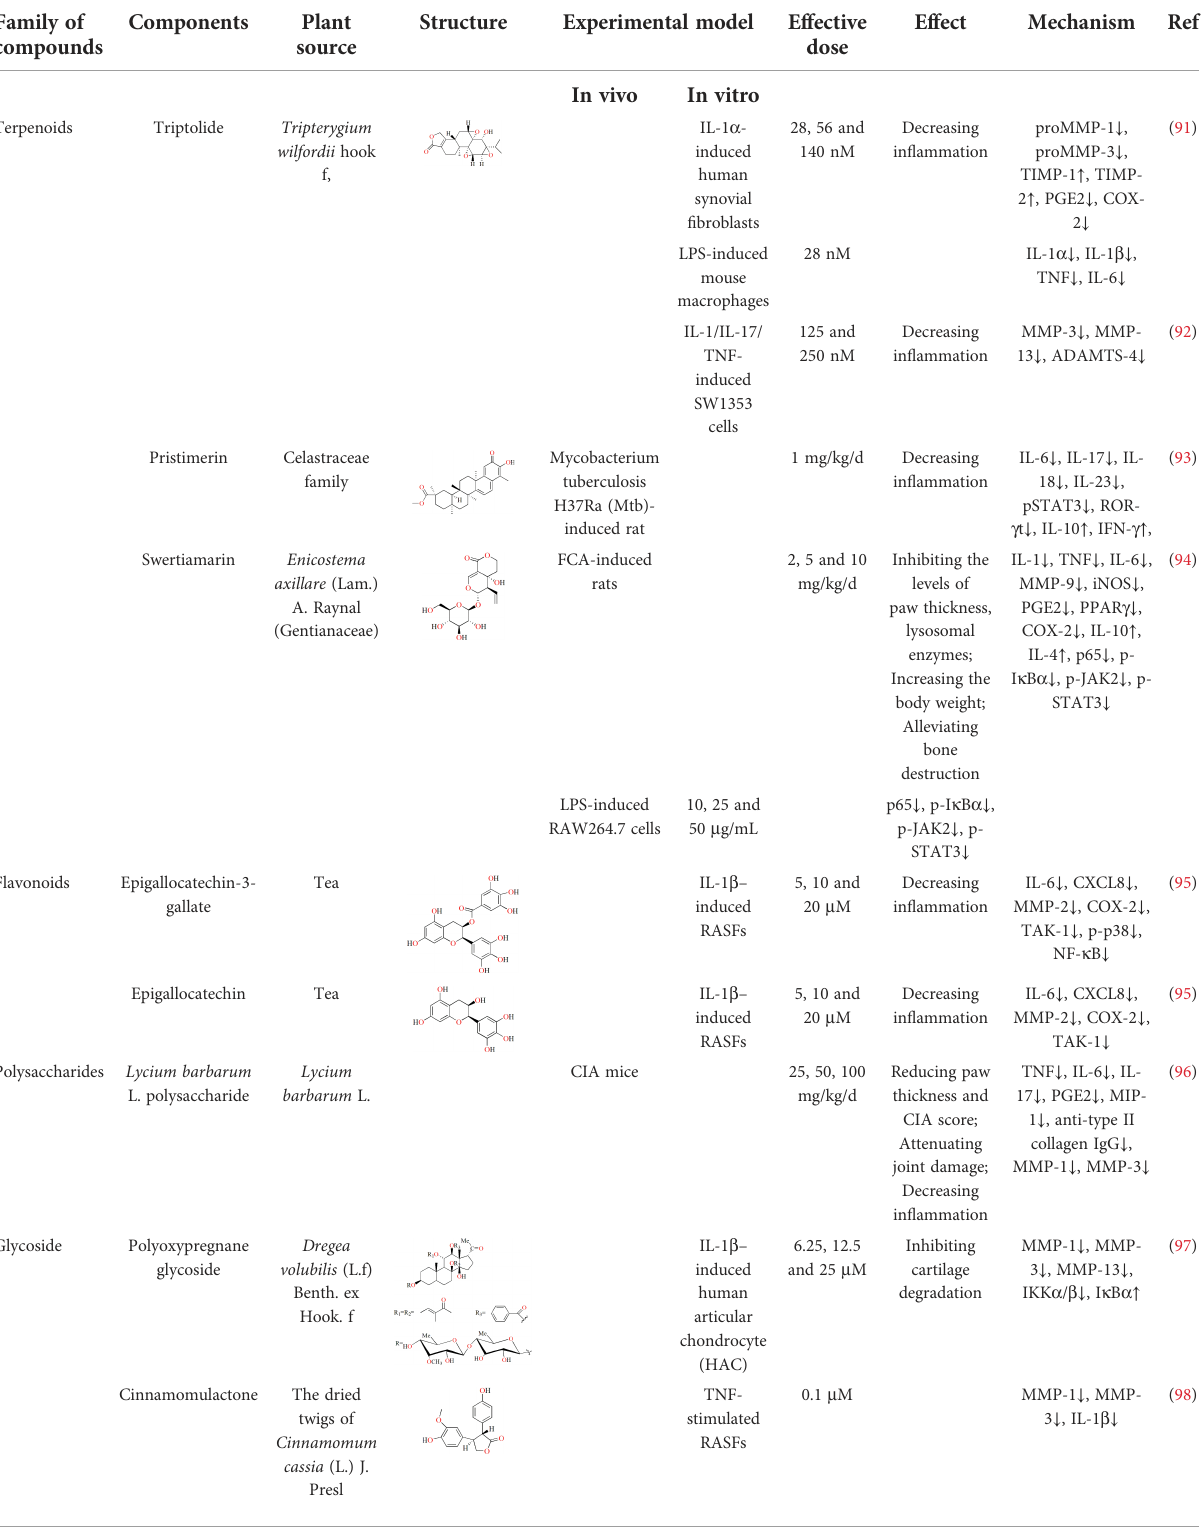
TABLE 3 Monomers from herbal medicines that can treat rheumatoid arthritis by regulating MMP. Family of